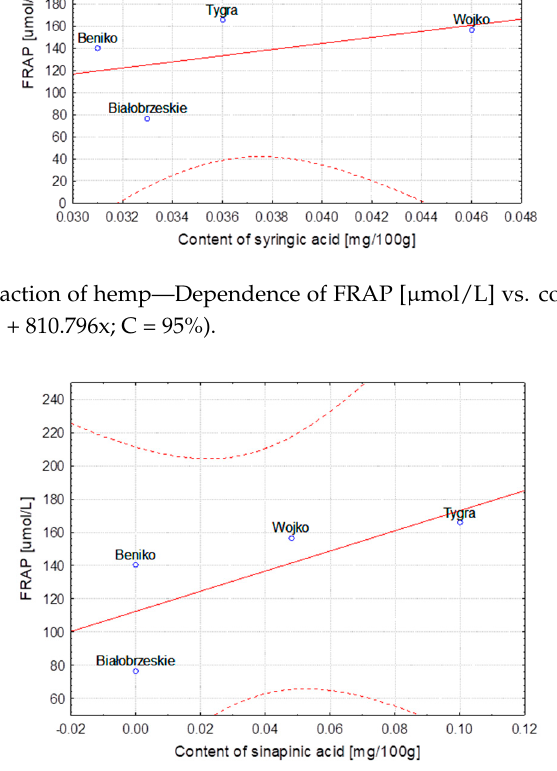
Figure 3. Method extraction of hemp—Dependence of FRAP [ μ mol/L] vs. content of sinapinic acid [mg/100 g] (y = 98.140 + 195.548x; C = 95%).